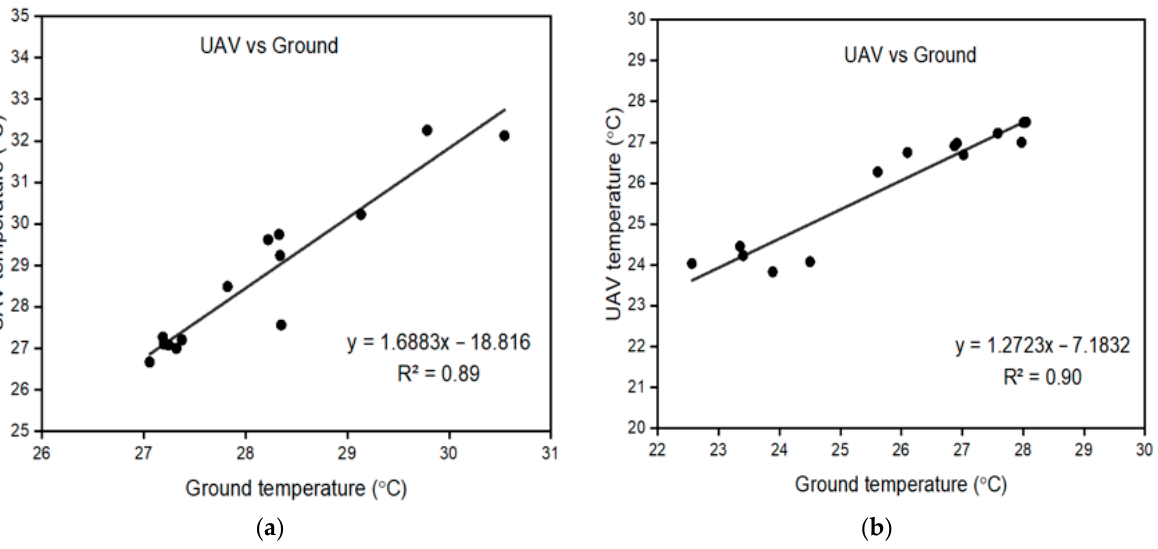
Figure 7. Relationship between the UAV-TIR sensor and the ground measurements, ( a ) DOY 230, ( b ) DOY 245. Table 7. Statistical performance of the UAV with ground measurements. Comparison DOY R 2 RMSE MAE BIAS CC UAV vs. Ground